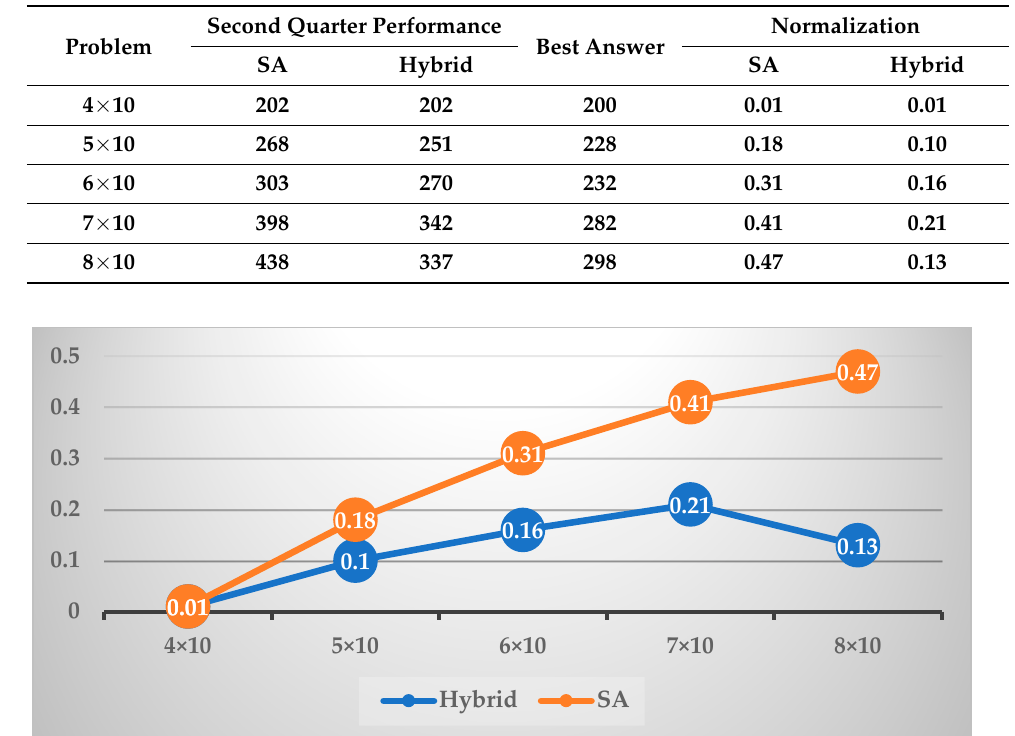
Table 5. Results of executing the SA and hybrid SA algorithms in the second quarter (10 ORs).